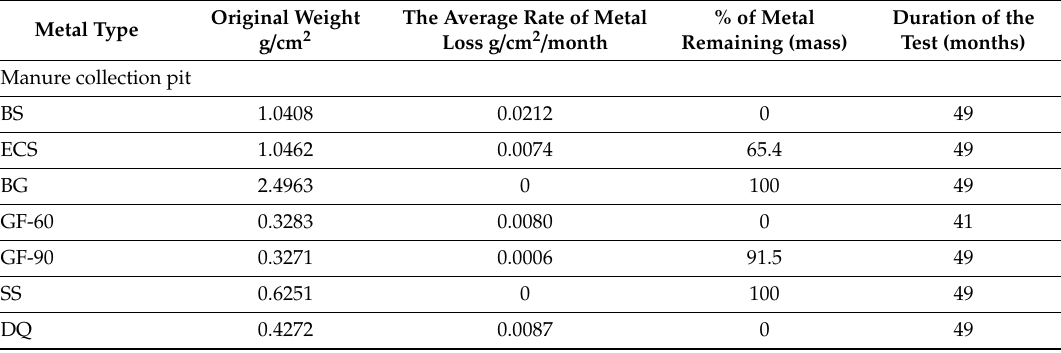
Table 3. Metal losses due to corrosion following exposure to dairy manure environments [3]. “Reproduced with permission from Safley, L.M.; Westerman, P.W., Bioresour. Technol. published by Elsevier,